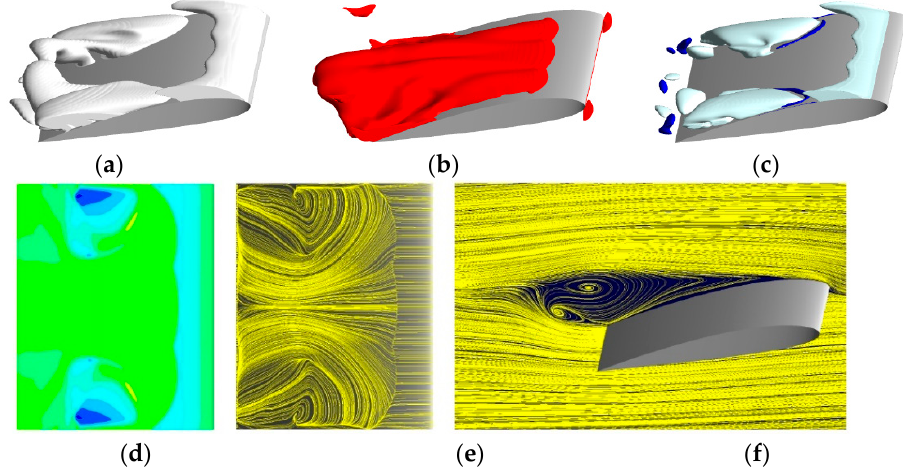
Figure 21. Time instant 1. ( a ) 3D view of cavitation regions (in white); ( b ) Back-flow regions (in red); ( c ) evaporation regions (in light cyan) and condensation regions (in dark blue); ( d ) temperature differences on hydrofoil suction side; ( e ) vector lines on hydrofoil suction side; ( f ) vector lines in symmetry plane.